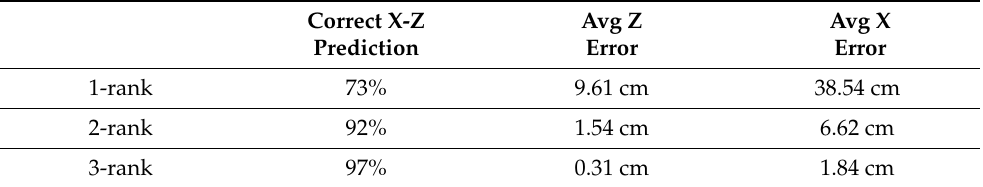
Table 1. Depth (Z-value) and horizontal position (X-value) prediction from